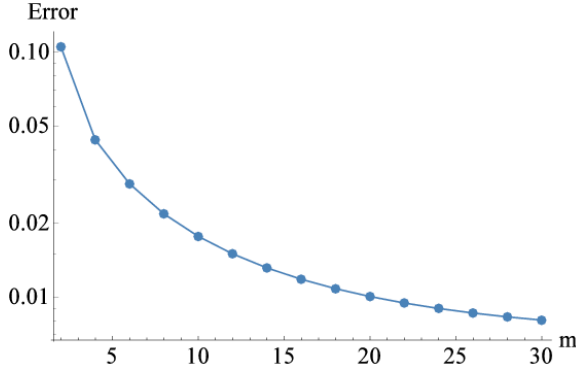
Figure 3. The total square residual error for the MWCNT nanofluid. The impact of the parameters ,Re, , M φ versus skin friction with SWCNTs and MWCNTs is displayed in Table 4. The larger values of the Marangoni convection parameter, M , enhances the skin friction and this effect is stronger in the SWCNTs, as shown in Table 4. The strong inertial forces stop the fluid motion and therefore the larger amount of Re enhances the skin friction. Further, this impact is more dominant in the case of SWCNTs, as exhibited in Table 4. The increasing value of the nanoparticle volume fraction, φ , decreases the skin friction. In fact, larger values of φ enhance the thermal efficiency of the fluid to increase the velocity field and reduce the skin friction. The effect is more specific in the SWCNTs.